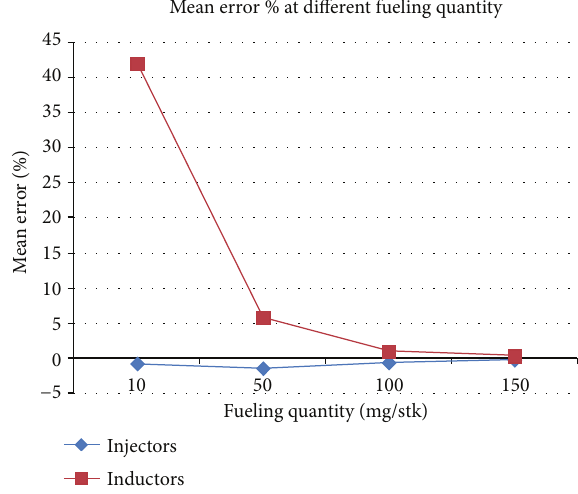
Figure 7: Comparing error % against engine speed for injectors and inductors.